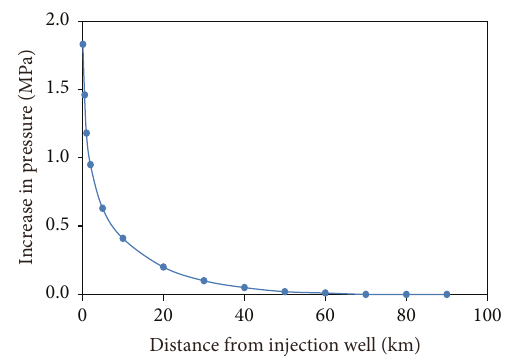
Figure 11: Pressure increases at the monitoring points during injection in the 10th